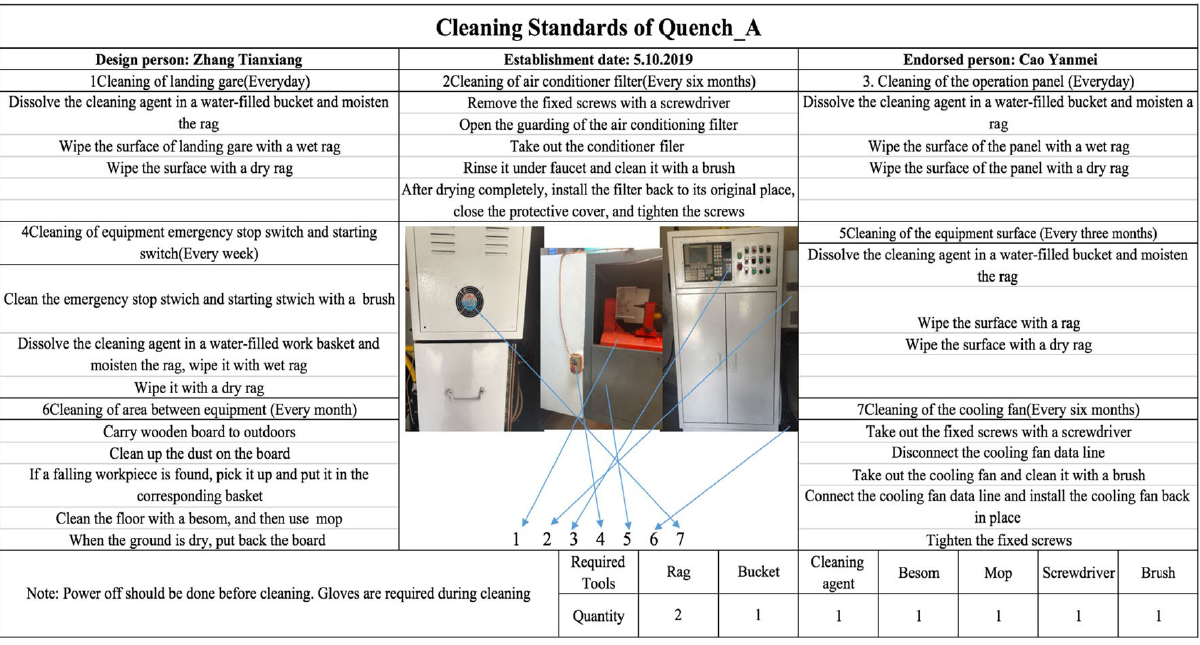
Figure 7. Cleaning standards for Quench_A (Actual display is in Mandarin)